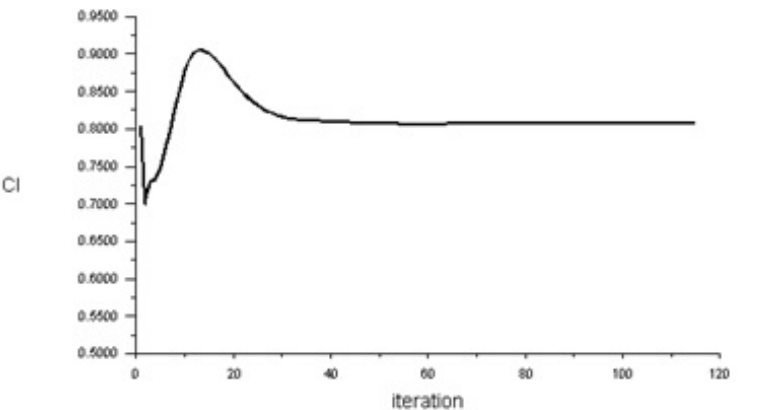
Figure 2. Computational analysis. ( a ) Polyhedral mesh of NACA 0012. ( b ) Polyhedral mesh of 1RR HPBA. ( c ) Iteration curve of 1RR